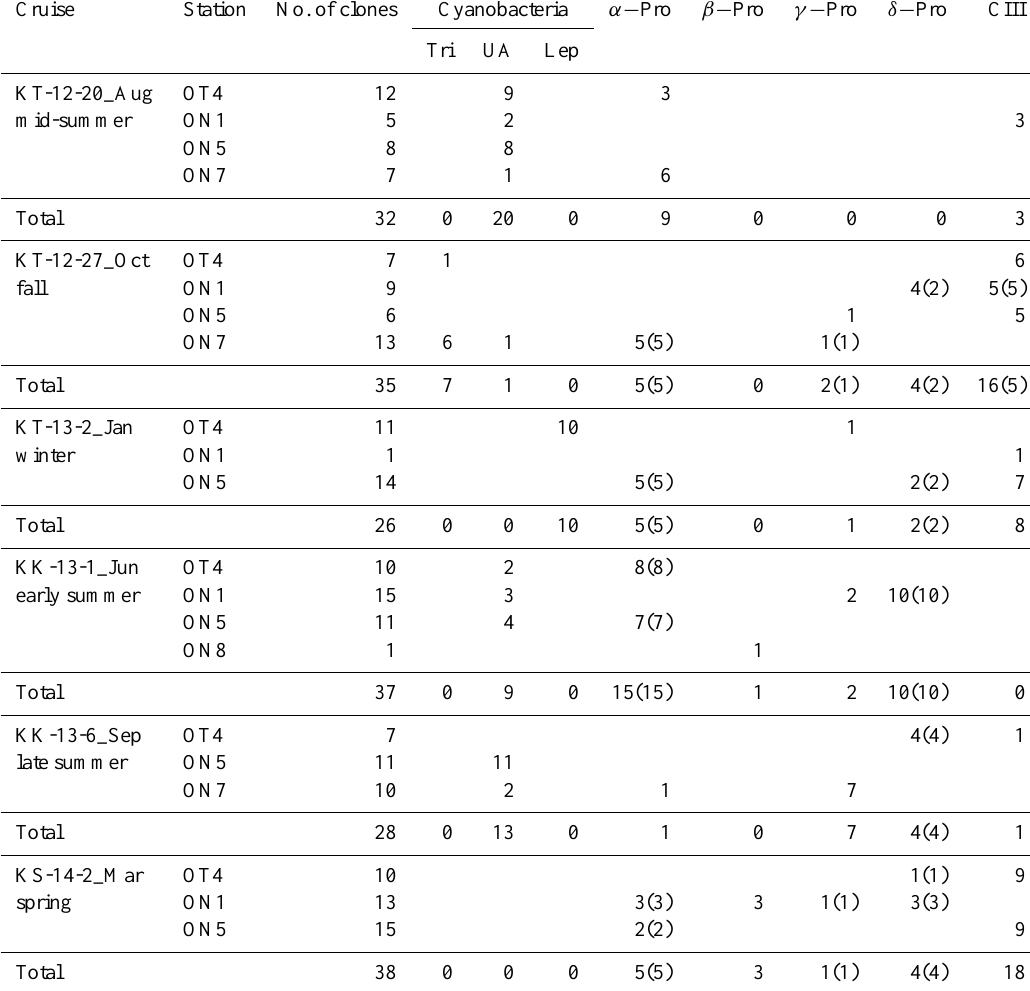
Table 1. Summary of recovered nifH sequences belonging to Trichodesmium (Tri), UCYN-A (UA), Leptolyngbya (Lep), α -Proteobacteria ( α -Pro), β -Proteobacteria ( β -Pro), γ -Proteobacteria ( γ -Pro), δ -Proteobacteria ( δ -Pro), and Cluster III